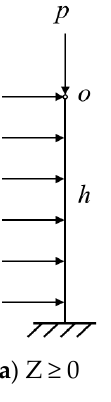
Figure 3. Simplified mechanical model of coal wall spalling.